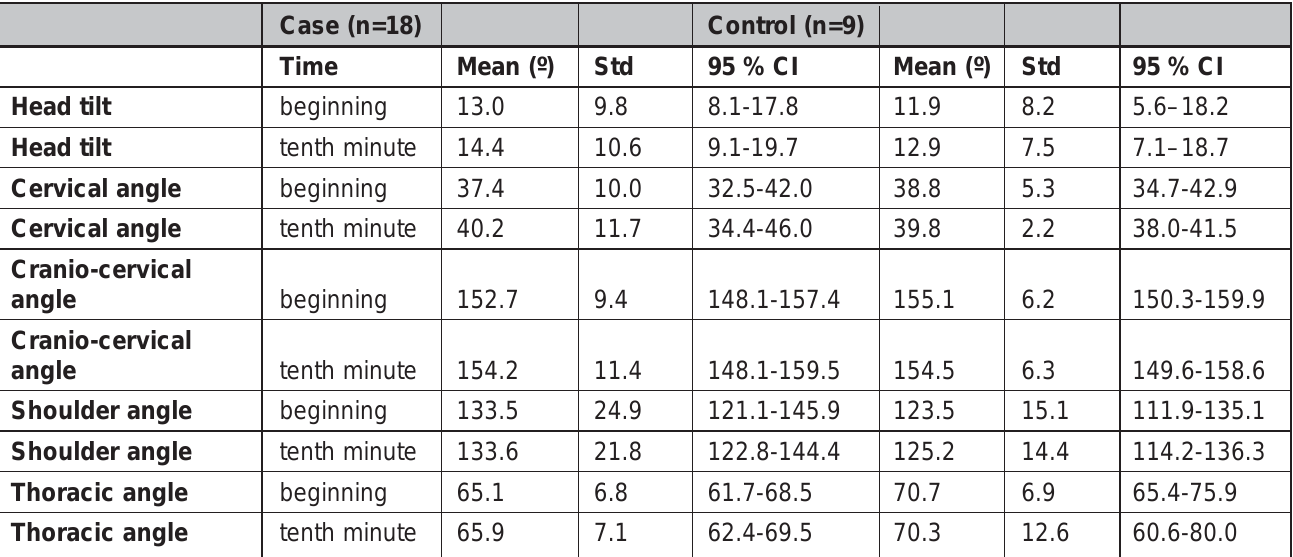
Table 2: Descriptive data of the postural angles (in degrees) of the case (n=18) and control groups (n=9)